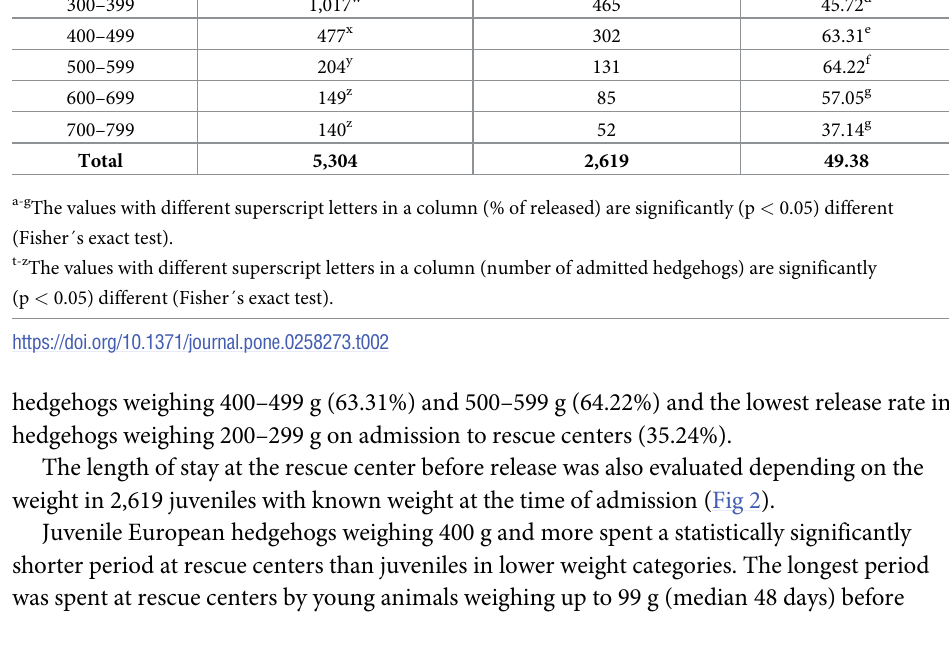
Table 2. Number of juvenile European hedgehogs admitted to rescue centers depending on weight and release rate. Weight (g) Number of admitted Number of released % of released up to 99 598 t 100–199